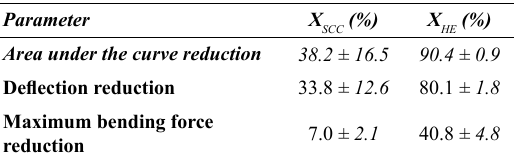
Table 4. Area under load vs deflection curve reduction, deflection reduction and maximum bending force reduction for martensitic material with (X ) and without cathodic protection (X HE SCC